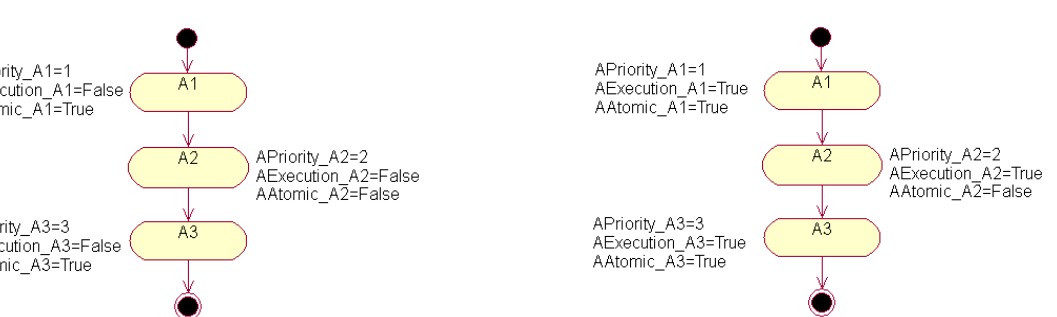
Fig. 10 . Tags initialization after running the corresponding